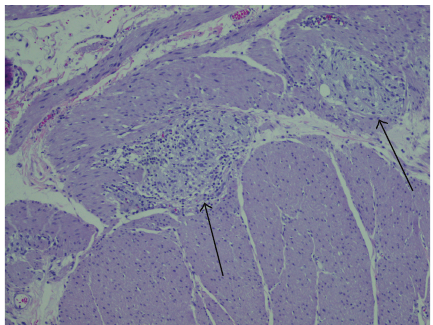
Figure 2: Mid-power cross section showing lymphocytic infiltrate into the myenteric